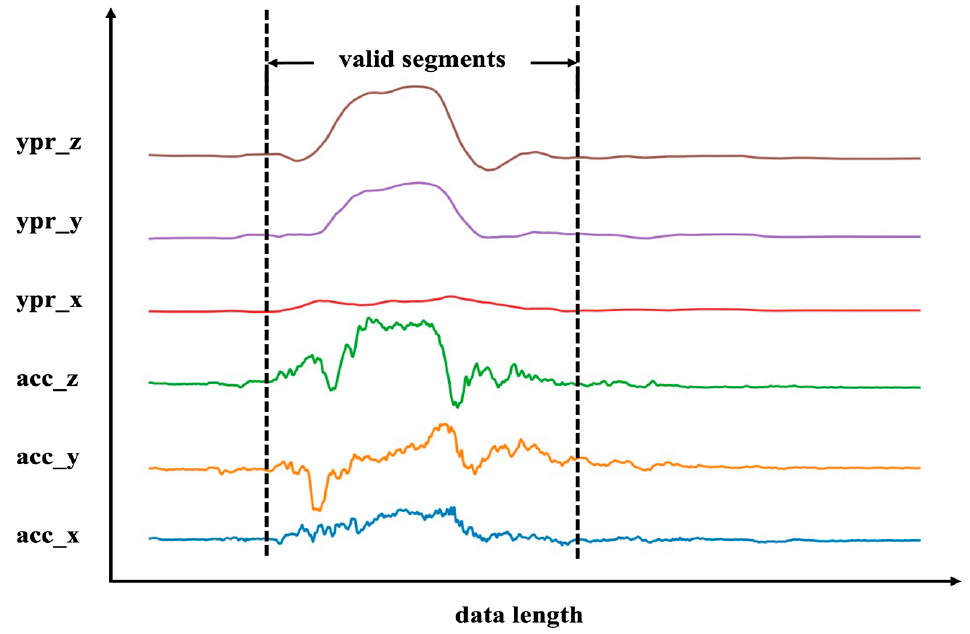
Figure 2. Take action 6 as an example to display the data of each channel of the back sensor. The lines from bottom to top represent the accelerometer x -axis(acc_x), y -axis(acc_y), z -axis(acc_z), gyroscope x -axis(ypr_x), y -axis(ypr_y), and z -axis(ypr_z). Valid segments of motions are shown within dashed lines.